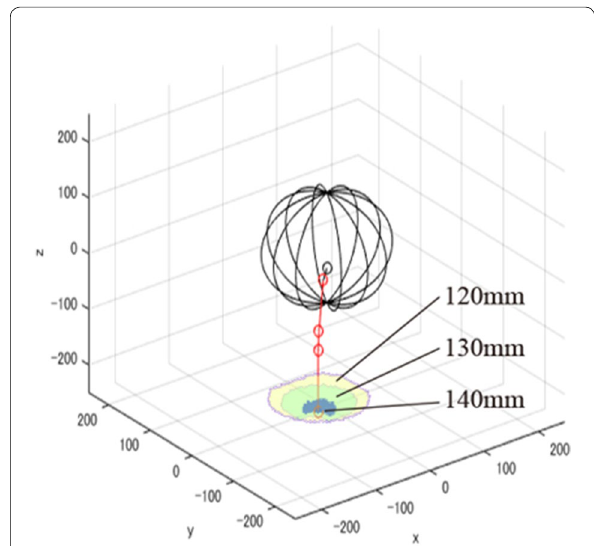
Fig. 23 Work ranges of foot at distances from the spherical outer shell